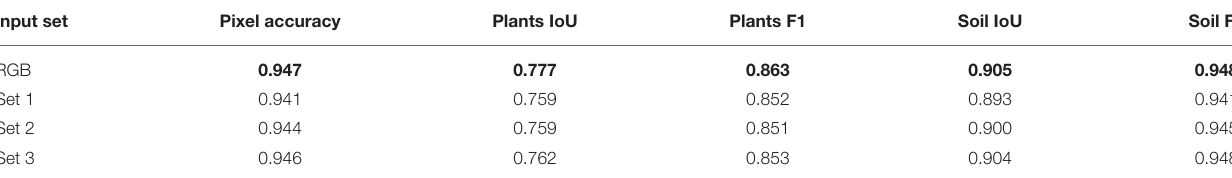
TABLE 9 | Input transformations, for overview of transformations refer to Table S1